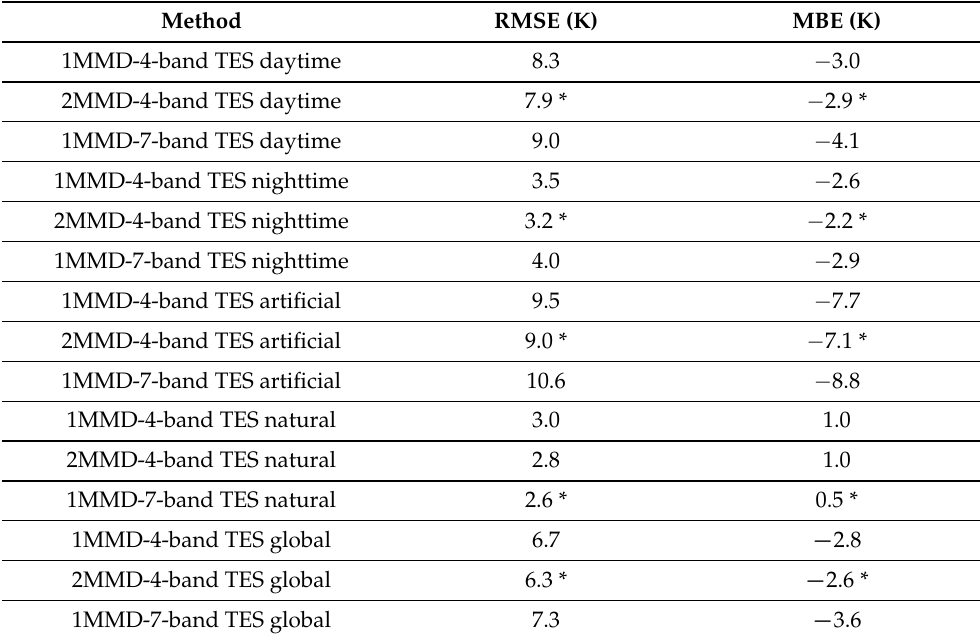
Table 8. RMSE, MBE between the retrieved LSTs for each method and the ground LSTs combining all the six available flightlines. * indicates the lowest RMSE